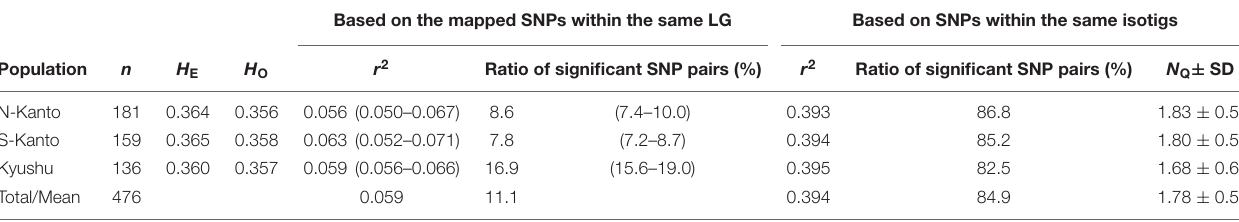
TABLE 1 | Summary of population genetics characteristics. Based on the mapped SNPs within the same LG Based on SNPs within the same isotigs